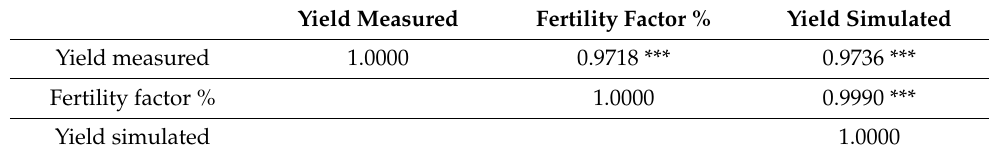
+7.95 Table 9. Correlation of measured (y) and simulated (x) yields. Data y = 0.8913x